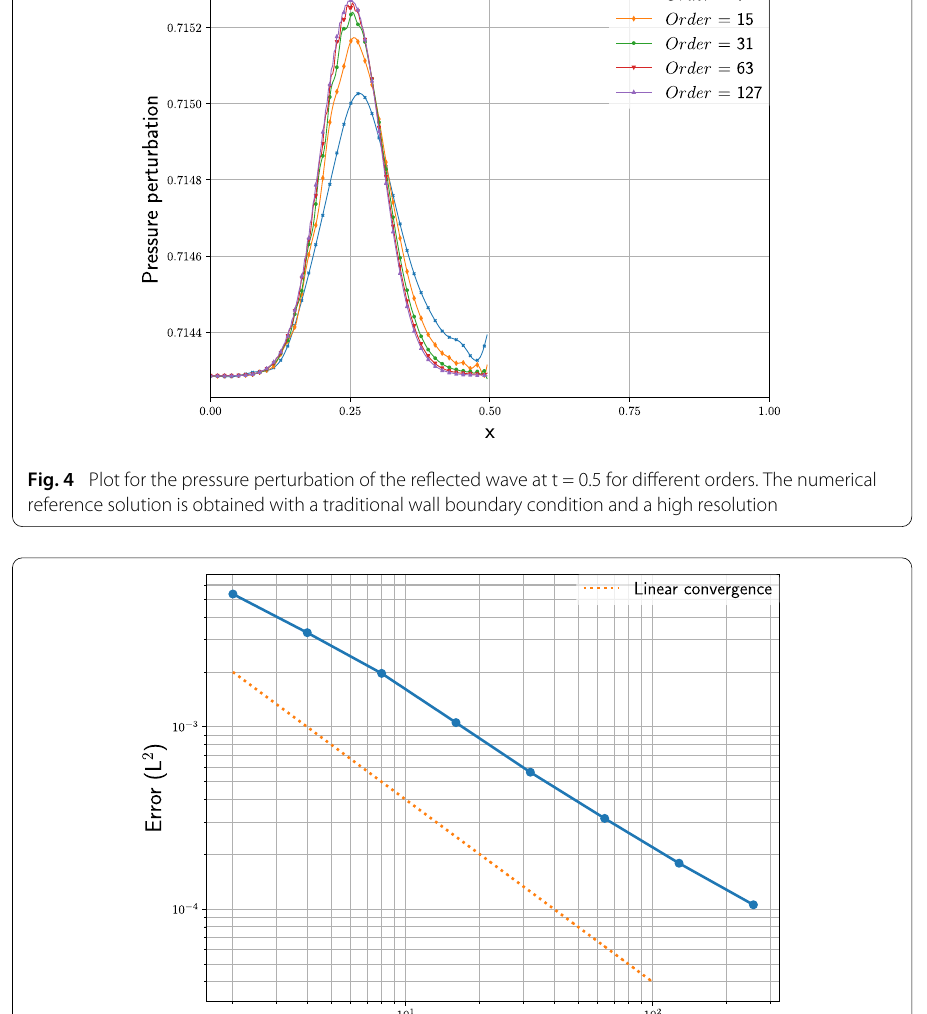
shift of the reflected wave gets diminished with increasing orders. With sufficiently large degrees of freedom, the wave shows an excellent agreement with the reference